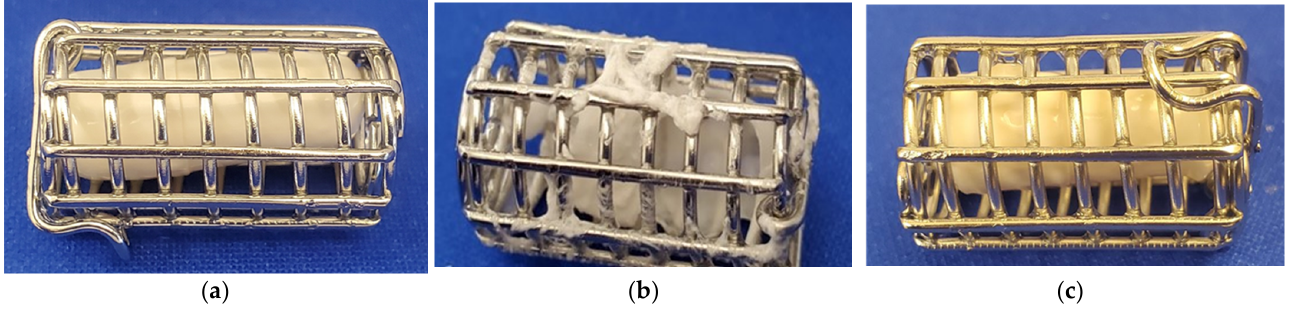
Figure 2. Vcaps ® Enteric capsules filled with 450 mg of drug after two hours of exposure to pH 2 acid phase: ( a ) Capsules filled with acetaminophen; ( b ) capsules filled with atenolol; ( c ) capsules filled with trimethoprim.